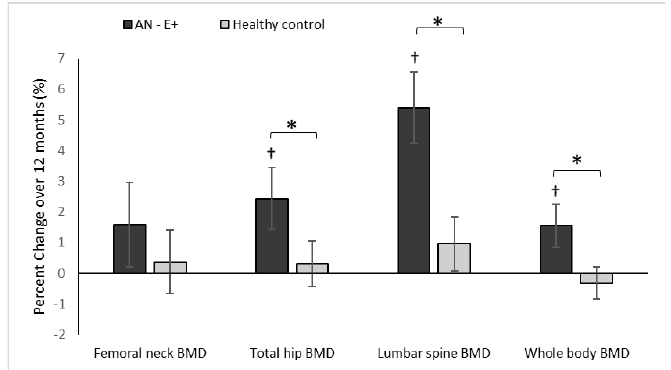
Figure 1. Percent change in DXA measures of areal BMD (bone mineral density) in the AN-E+ and healthy control groups over 12-months, * p < 0.05 for between group comparison after adjusting for age and race, † p < 0.05 for within group change.